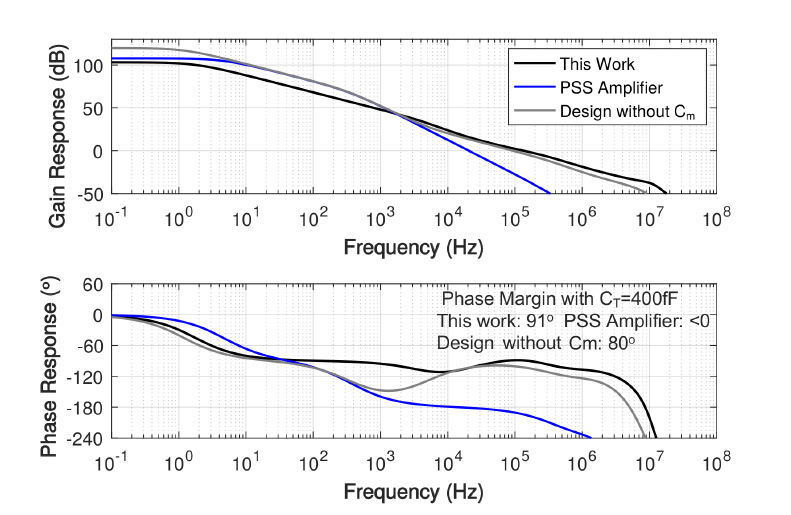
Figure 12. Comparison of simulated frequency response among this work, the PSS amplifier [42] and the design without C m with 2.5-nF load capacitance and 400-fF total compensation